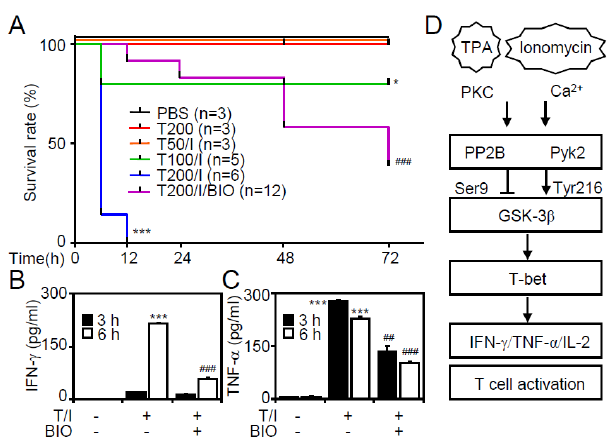
Figure 6. Treatment with a GSK-3β inhibitor reduces T/I-induced mortality and cytokine production in vivo . ( A ) Survival rate of mice following T/I treatment with or without BIO therapy. Six groups were included: PBS (n = 3 for control), T200 (n = 3; TPA, 200 μg/kg), T50/I (n = 3; TPA, 50 μg/kg plus ionomycin, 250 μg/kg), T100/I (n = 5; TPA, 100 μg/kg plus ionomycin, 250 μg/kg), T200/I (n = 6; TPA, 200 μg/kg plus ionomycin, 250 μg/kg), and T200/I/BIO (n = 12; TPA, 200 μg/kg plus ionomycin, 250 μg/kg plus BIO 2 mg/kg). ( B and C ) Mice were pretreated with BIO (2 mg/kg) for 0.5 h and were then stimulated with T/I (n = 3; TPA, 200 μg/kg plus ionomycin, 250 μg/kg) for the indicated time. ELISA determined the levels of IFN-γ and TNF-α in the mouse serum. The data are shown as the mean ± SD obtained from three mice. * p < 0.05 and *** p < 0.001 compared with the PBS-treated group. ## P < 0.01 and ### P < 0.001 compared with the T/I-treated group. ( D ) A model of GSK-3β-regulated cytokine production in T/I-activated human CD4 + T lymphocytes.